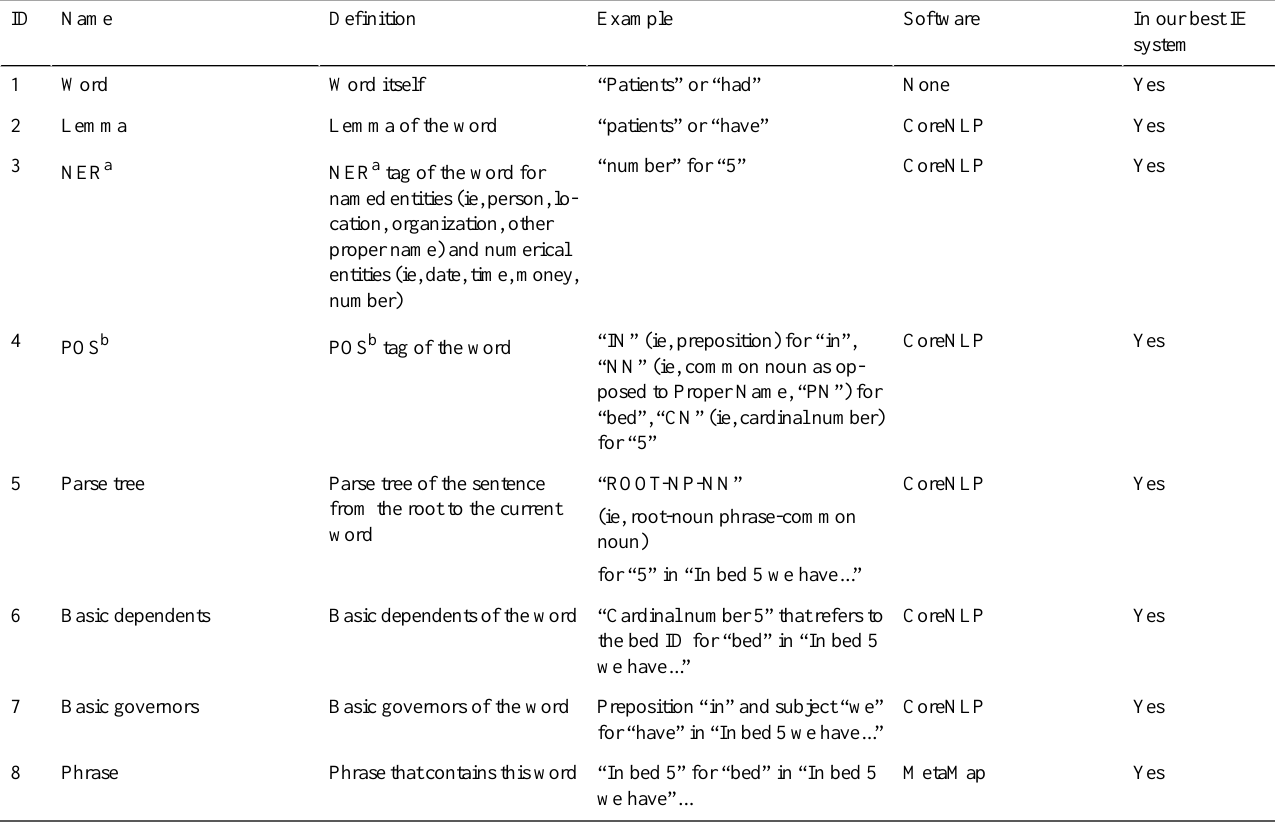
Table 1. Experimented syntactic features.